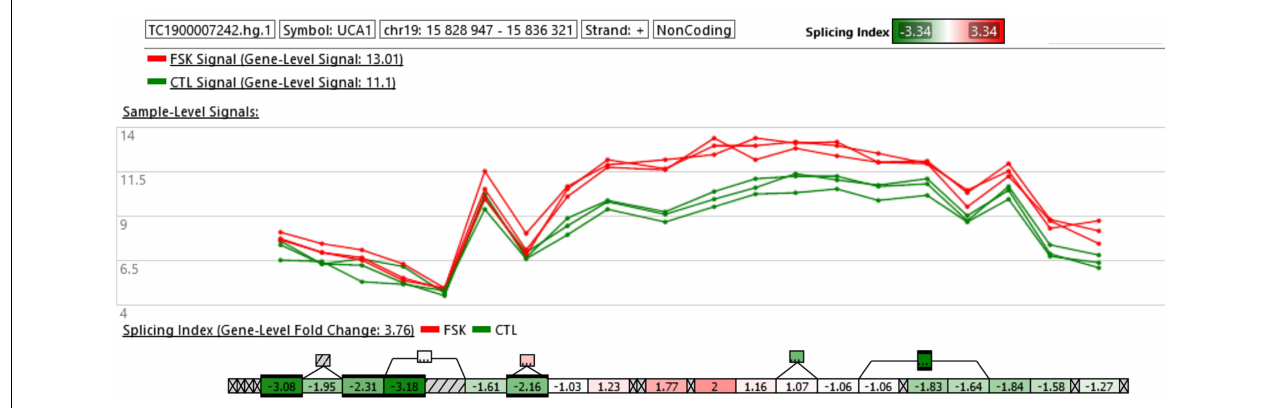
FIGURE 5 | Exon level analysis of UCA1. The microarray ClariomD provides information on the local fluorescence level of a series of probe and allows to calculate a local splicing index, comparing BeWo cells treated with FSK vs. BeWo cells treated by the DMSO as a vehicle. Isoforms lacking the first portion of the full transcript are more strongly expressed in the BeWo-FSK comparatively to the